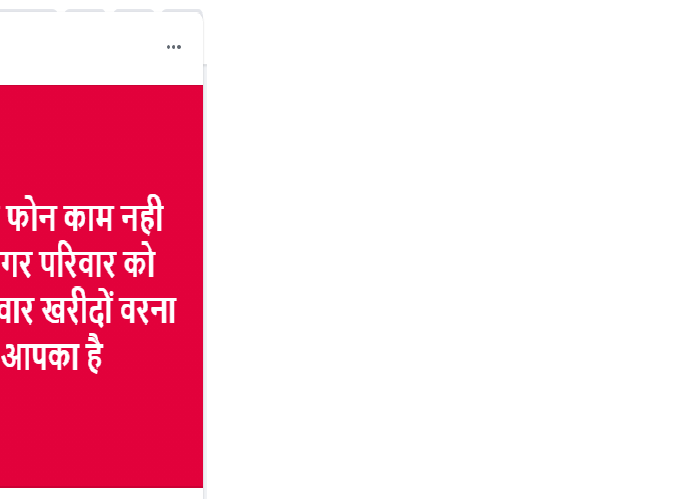
Figure 5. Facebook post on 24 February calling people to arm themselves. “25–50,000 phones will not be useful, Hindus if you want to save your families then buy a sword. You are next in queue (getting killed)”.